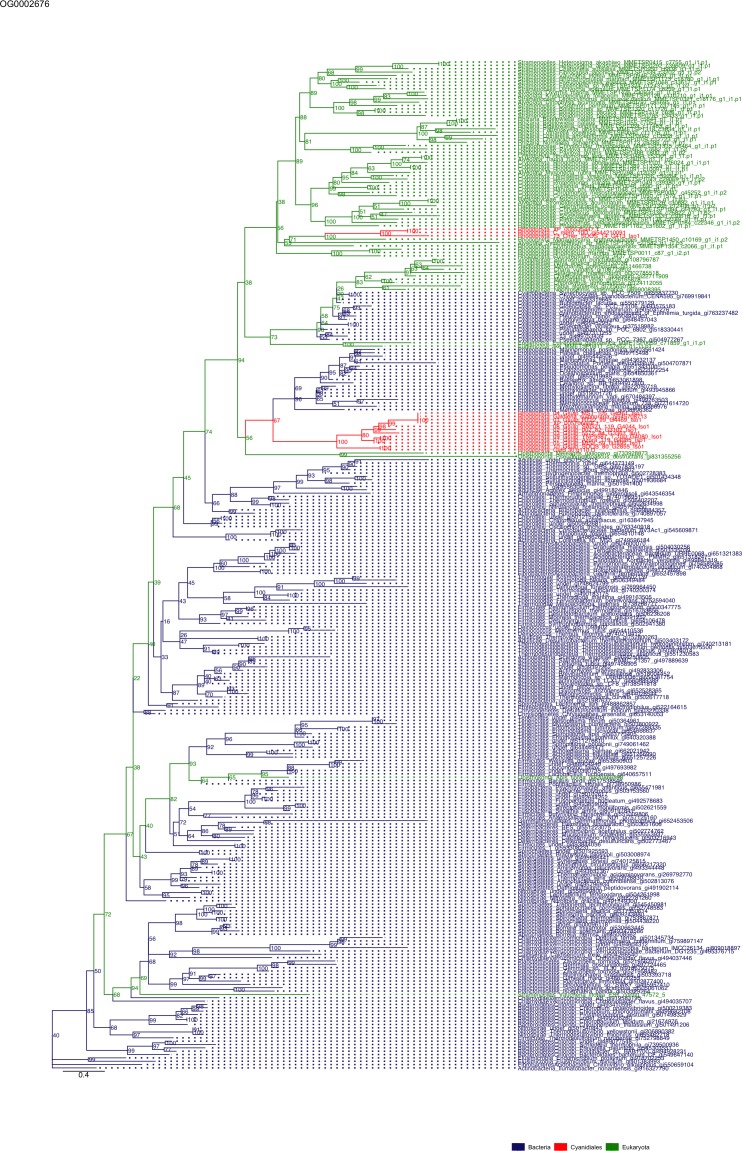
Sequence tree of orthogroup OG0002676.The tree is based on amino acid sequences. Archaea (yellow), Bacteria (blue), Cyanidiales (red), Eukaryotes including other red algae (green). Branches containing Cyanidiales sequences are highlited in red.